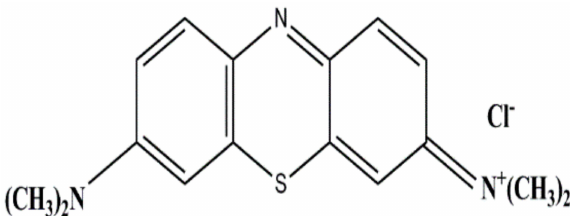
Figure 1. Chemical structure: MB chloride